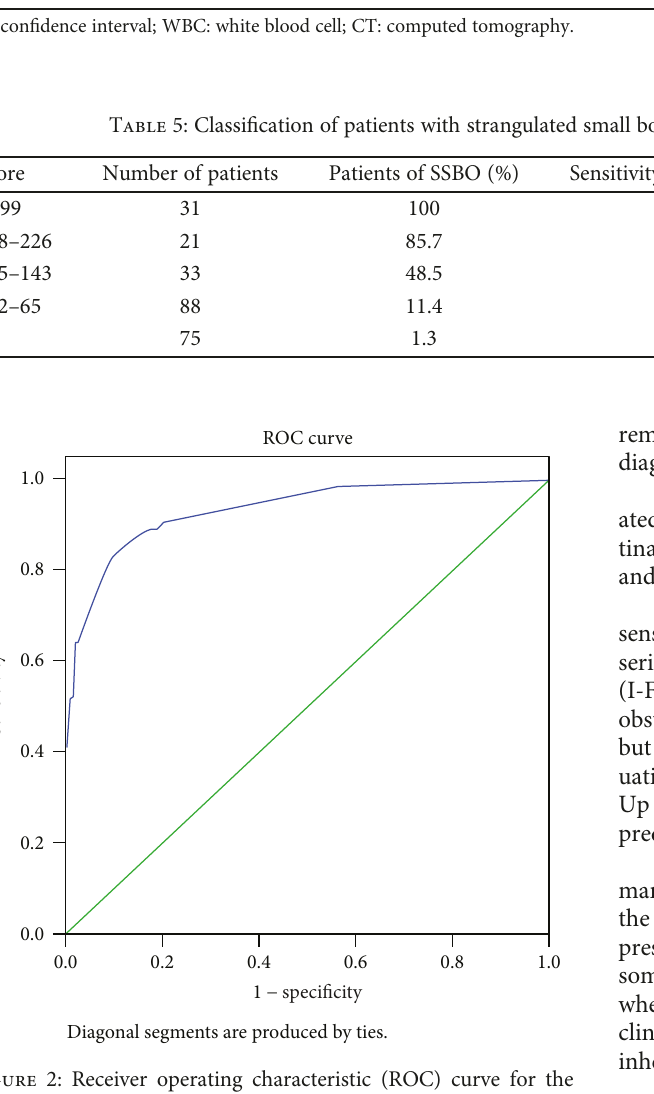
Figure 2: Receiver operating characteristic (ROC) curve for the prediction model. The area under the curve was 0.935 (95% CI, 0.900 –